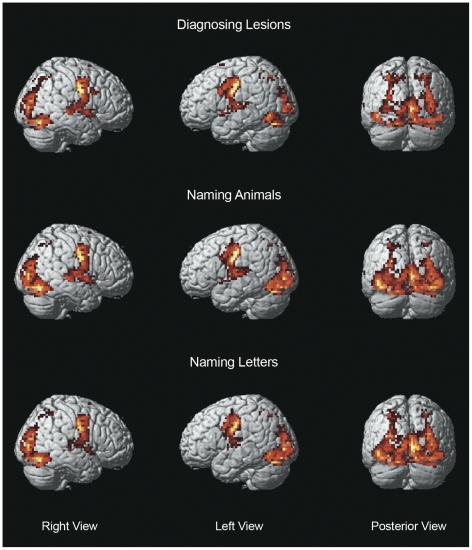
Cortical activations while diagnosing lesions and naming animals and letters versus control baseline *.*family wise error rate corrected p<0.05. Statistical parametric maps rendered on an International Consortium of Brain Mapping individual brain.